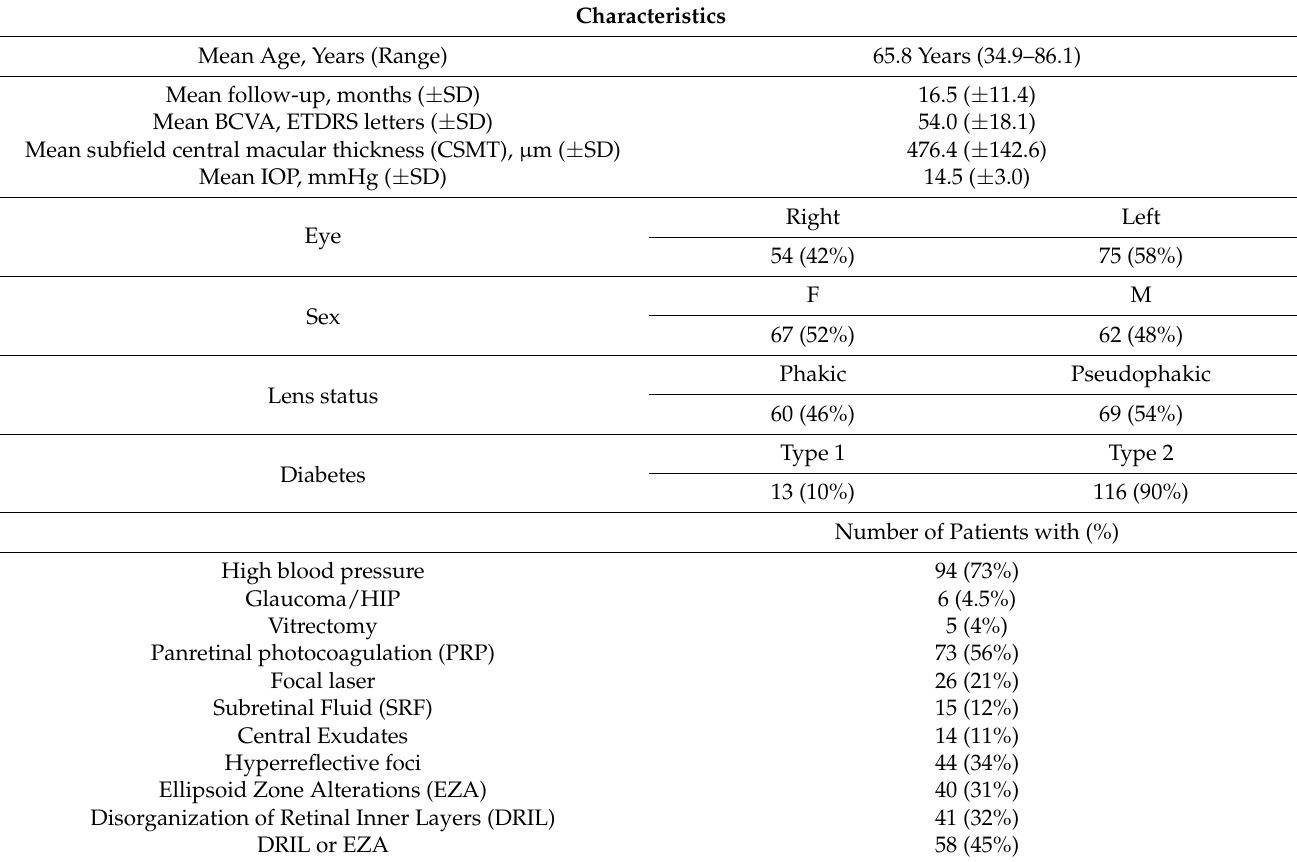
Table 1. Baseline characteristics of patients and study eyes. (BCVA = best-corrected visual acuity; CSMT = central subfield macular thickness; HIP = high intraocular